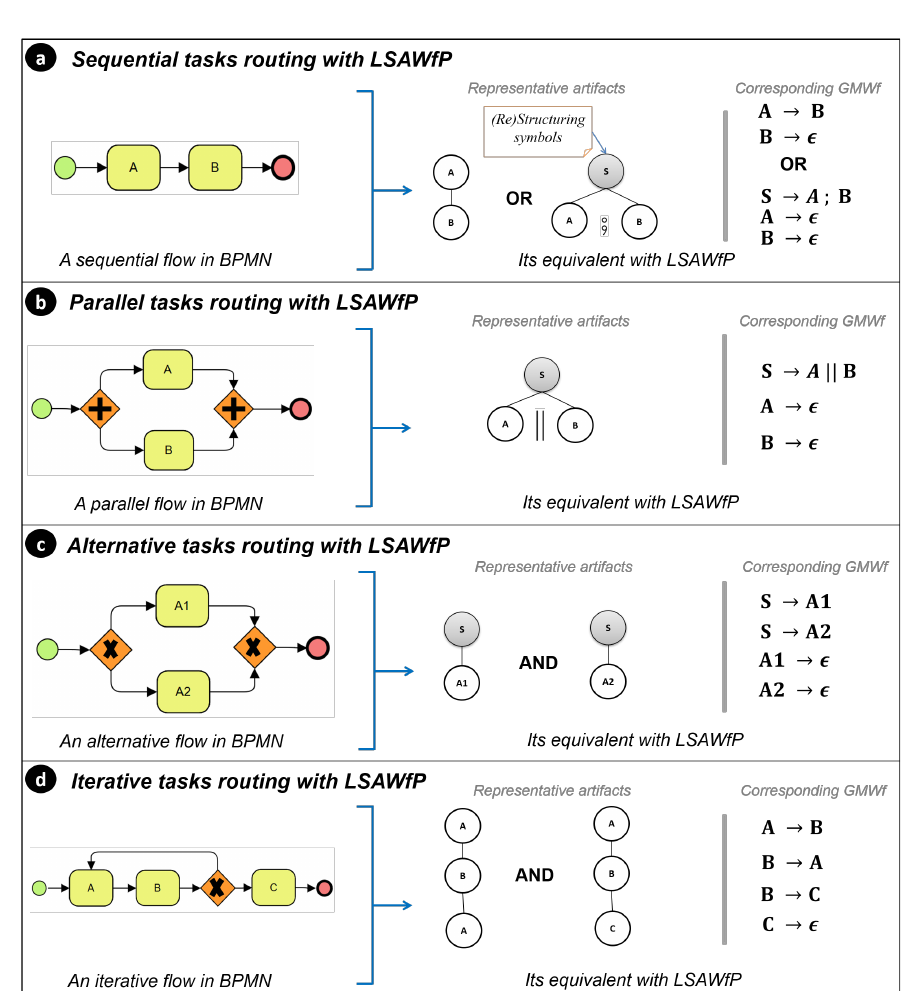
Figure 4: Illustrating basic control flows with